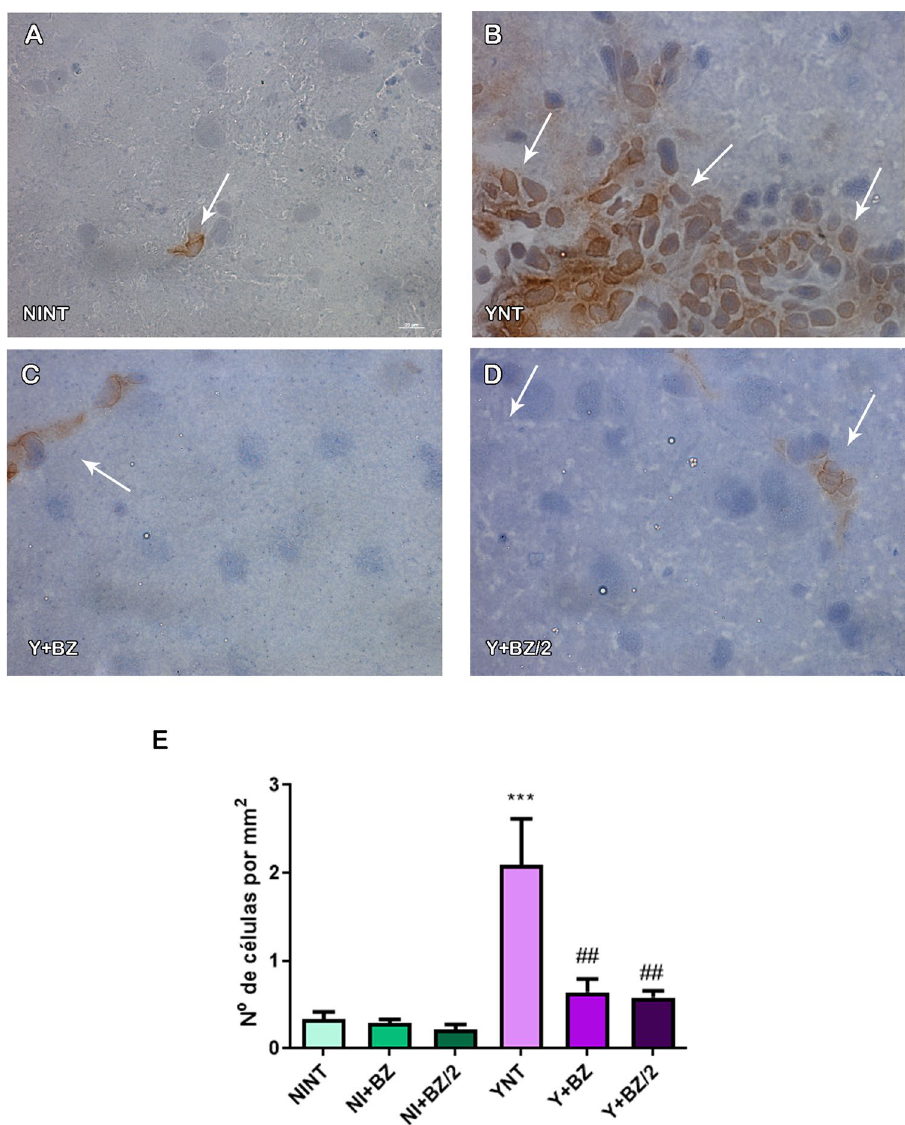
Figure 6. Analysis of the number of F4-80+ cells by immunohistochemistry in mice’s brain at 15 dpi. YNT group ( B ) presented increased number of F4-80+ cells when compared to NINT control group ( A ). Benznidazole treatment schemes ( C and D ) were able to prevent this increase. Graphic indicates the number of F4-80+ cells per mm 2 ( E ). Arrows indicate positive cells. NI: non infected, Y: infected, NT: non treated, BZ: treated with benznidazole (100 mg/kg/day), BZ/2: treated with benznidazole (50 mg/kg/day), dpi: days post- infection. *When compared to NINT; # when compared to YNT *p < 0.05, **p < 0.01, ***p <